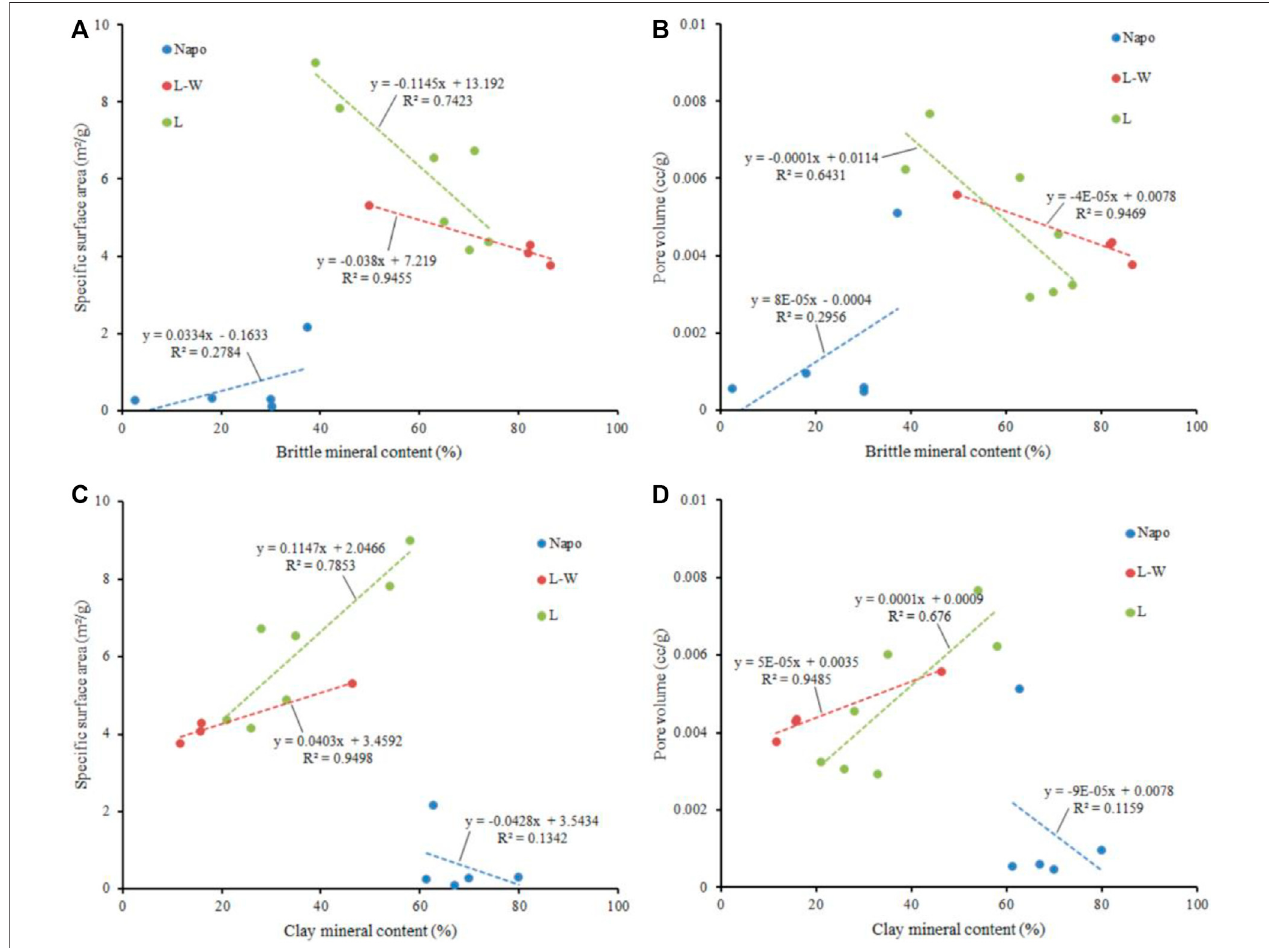
FIGURE 11 | Relationship between pore structure parameters and content of different mineral components of the shale samples. Notes: (A) Correlation between brittle mineral content and speci fi c surface area; (B) Correlation between brittle mineral content and pore volume; (C) Correlation between clay mineral content and speci fi c surface area; (D) Correlation between clay mineral content and pore volume; “ Napo ” - Napo Formation shales; “ L-W ” - Longmaxi and Wufeng Formation shales; “ L ” - Longmaxi Formation shale data from Ji et al., 2016.